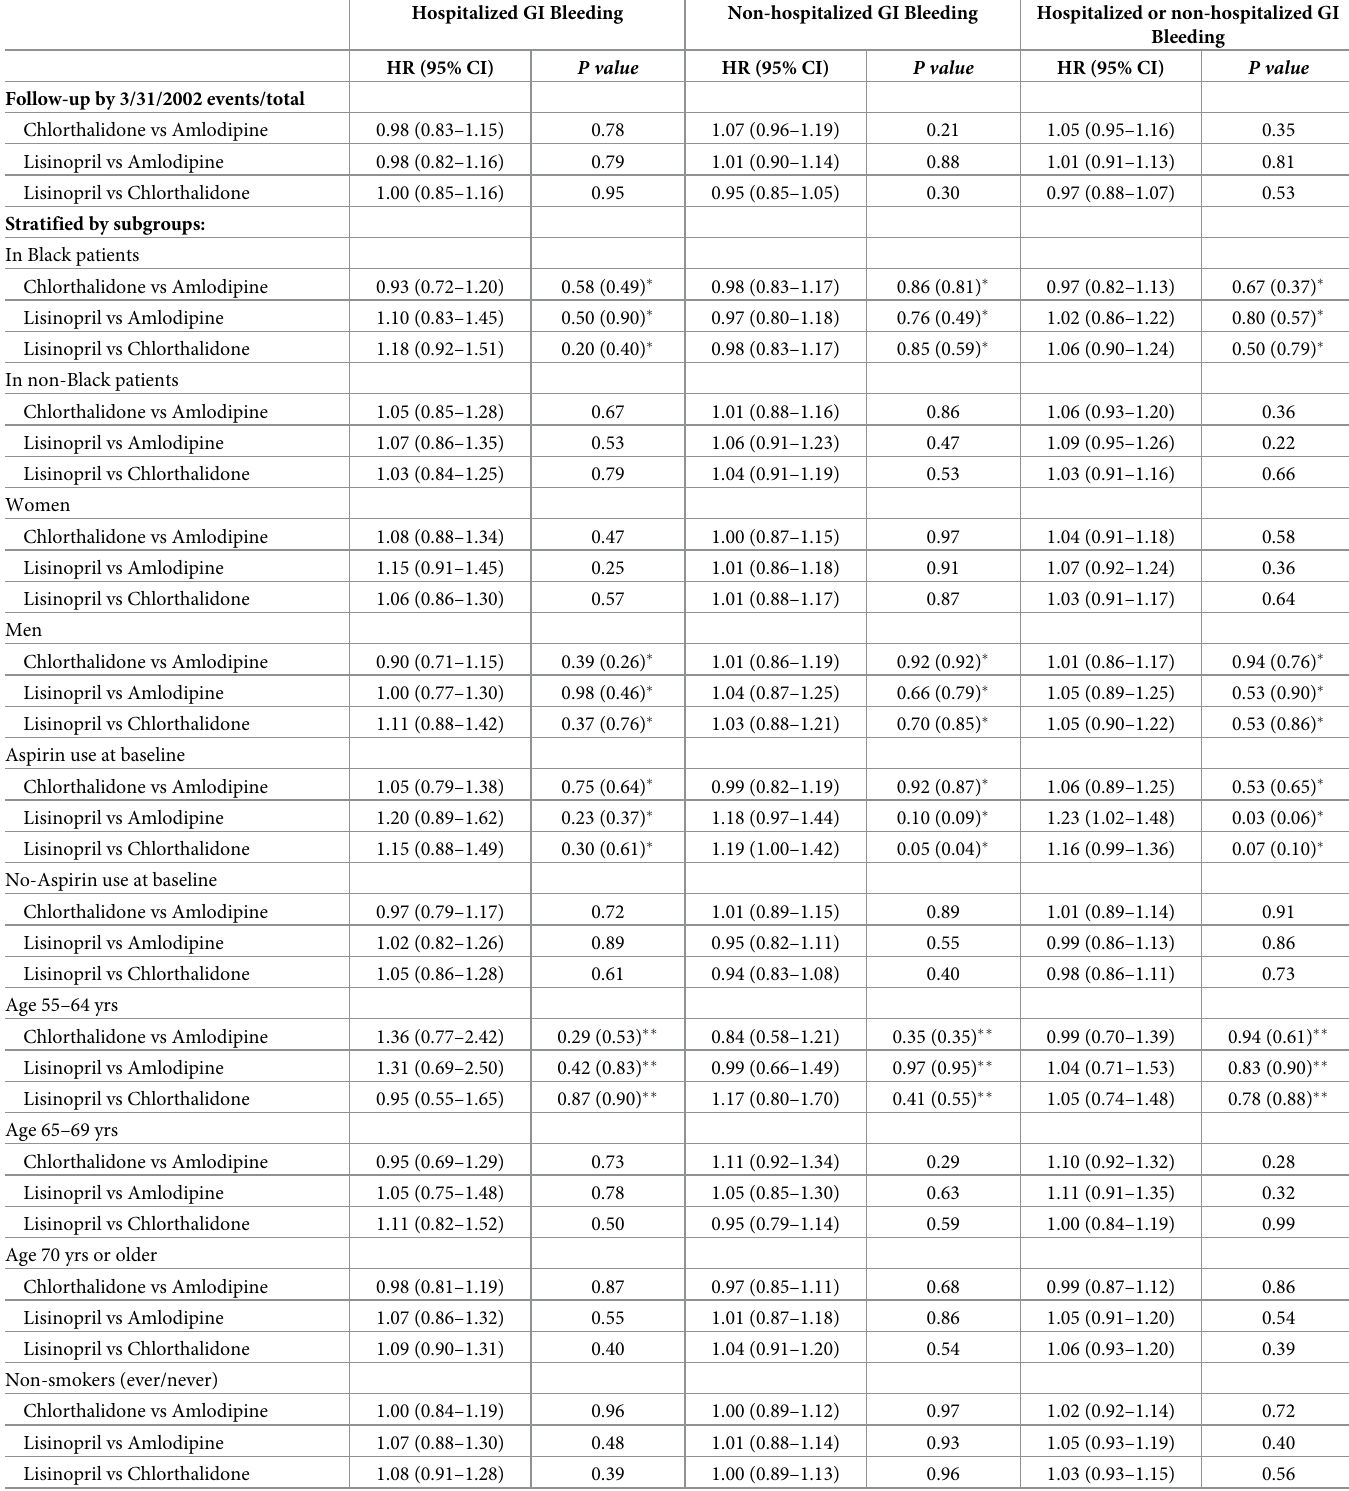
Table 3. Hazard ratios (95% CI) for GI bleeding within subgroup by 3 RCT arms